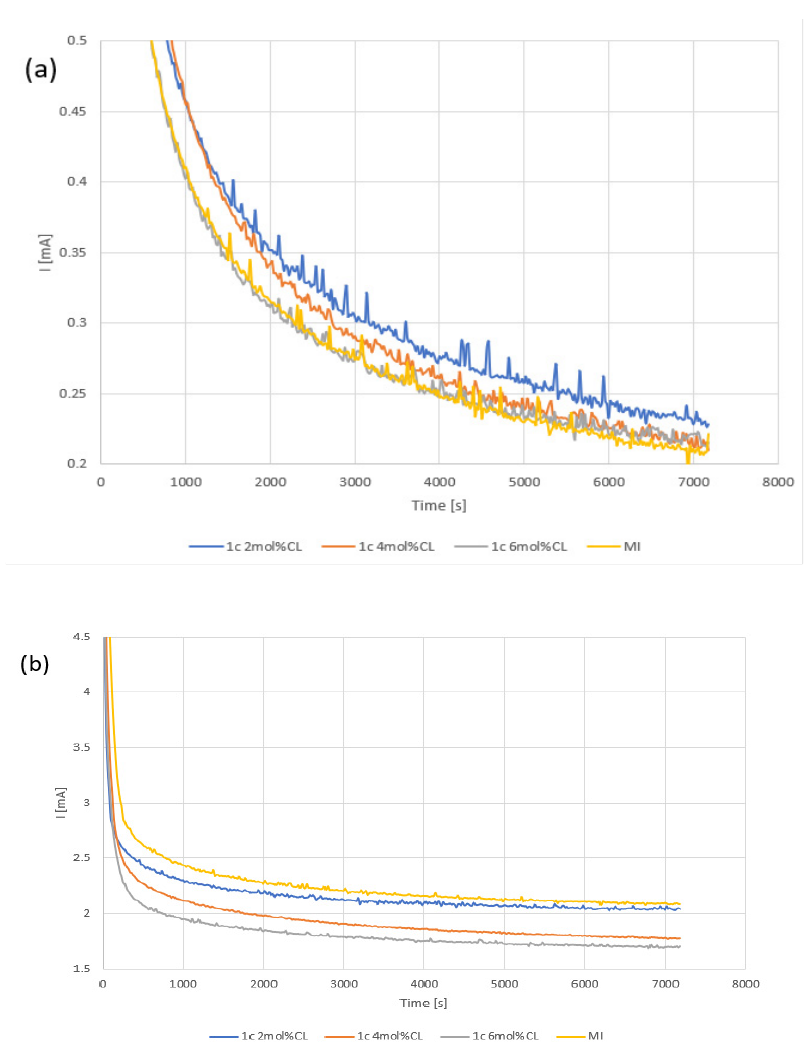
Figure 5. Chronoamperograms of electrodialysis experiments with 0.2 M phosphate buffer using AEM produced by the different cross linker concentrations. ( a ) Test at 1.0 V and ( b ) at 1.5 V. MI refers to AMI-7001 as a benchmark.